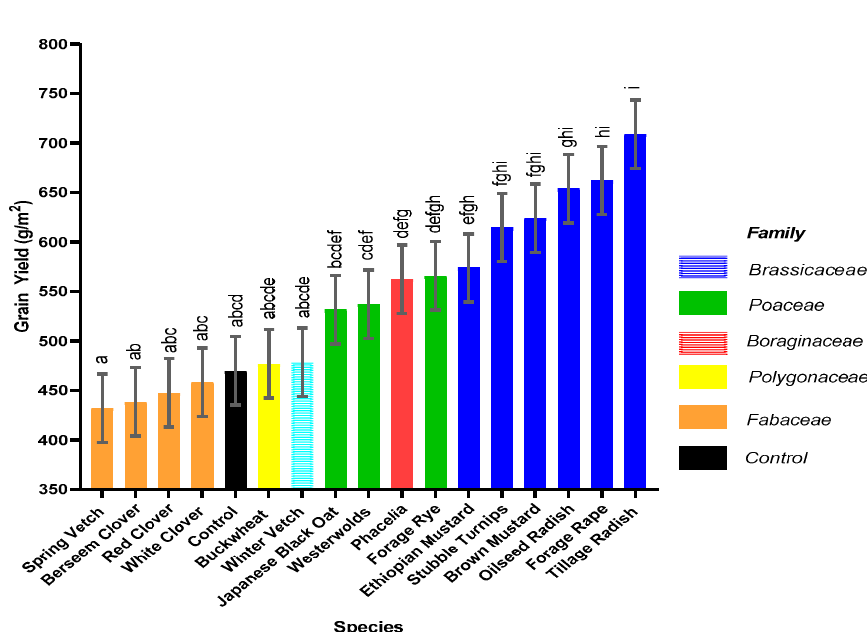
Figure 3. Grain yield post cover crop as affected by cover crop species (g/m 2 ). Bars represent species mean (N = 8) whilst the bar colour indicates the species family. Error bars represent Standard Error of the Mean (SEM). Letters represent significant differences between cover crops using Fisher’s Unprotected post-hoc test 0.05 LSD = 96.91. Means that do not share the same letters are significantly ( p < 0.05) different. Typical farm yields in Northern Ireland are 500 g/m 2 , high 650 g/m 2 , low 400 g/m 2 .